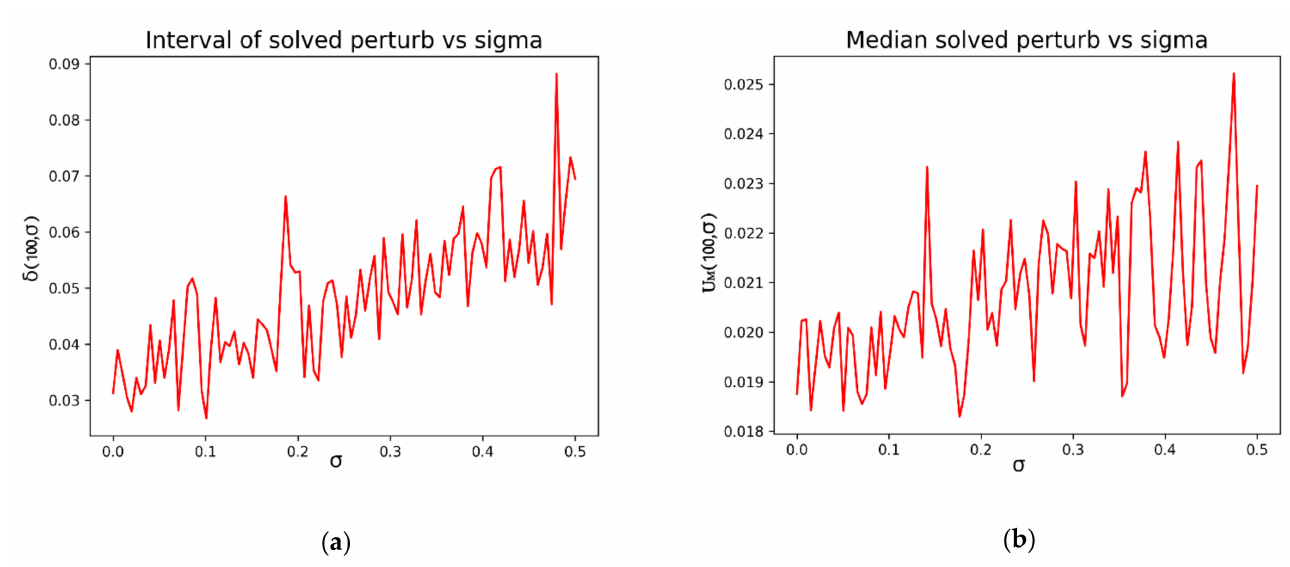
Figure 5. Effect on the solution of different standard deviation for 200 samples of the normal perturbation term: ( a ) Range of the differences δ ( 100, σ ) ; ( b ) Median of the difference between the numerical solutions and the exact solutions at right extreme of the interval U M ( 100, σ ) .